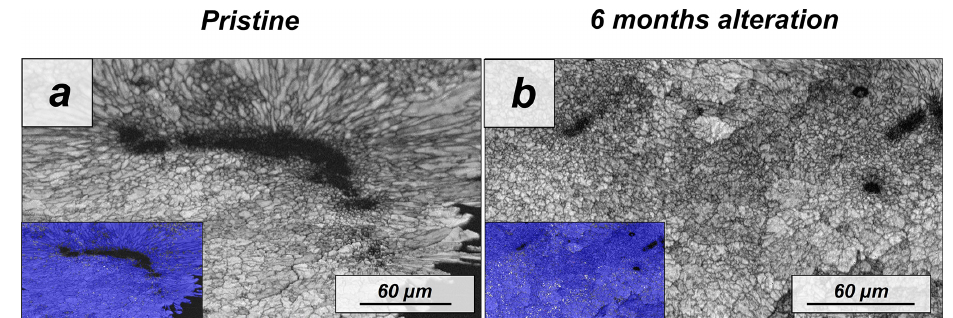
Figure A13. EBSD band contrast and phase maps illustrating the differences in microstructure and mineralogy between the pristine and the most altered skeletons of Porites